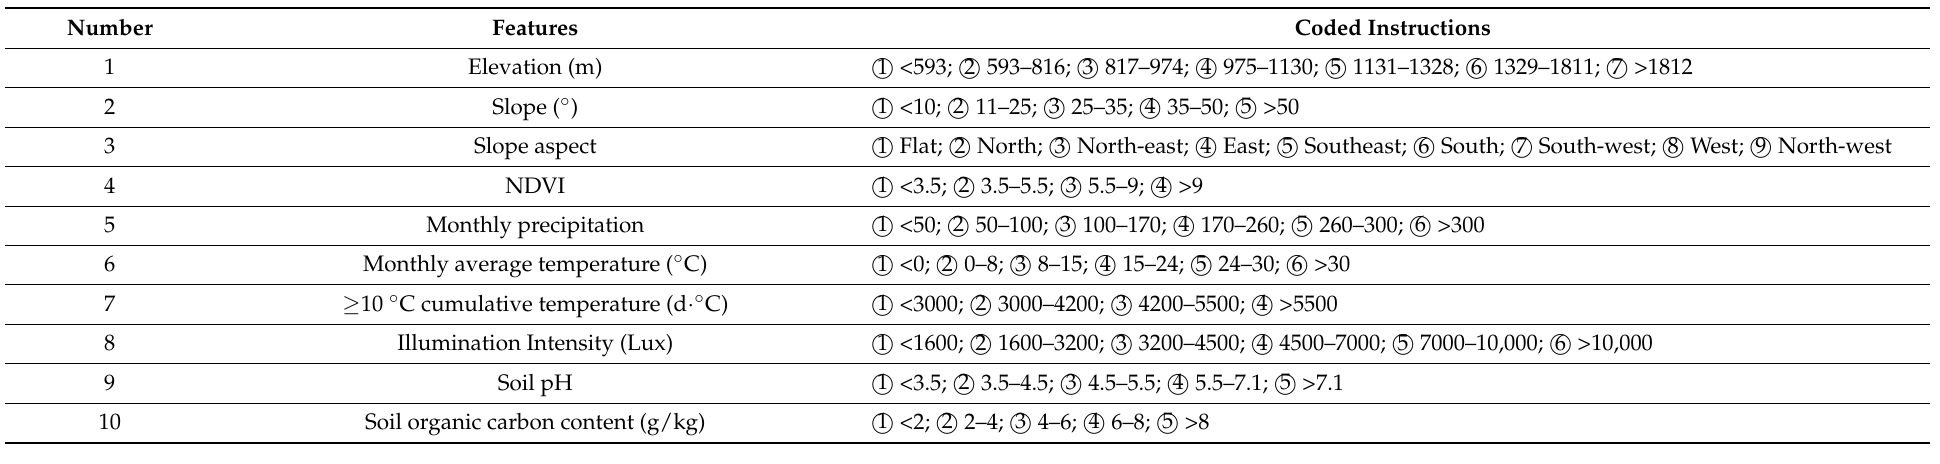
Table 3. Coding of suitability characteristics.